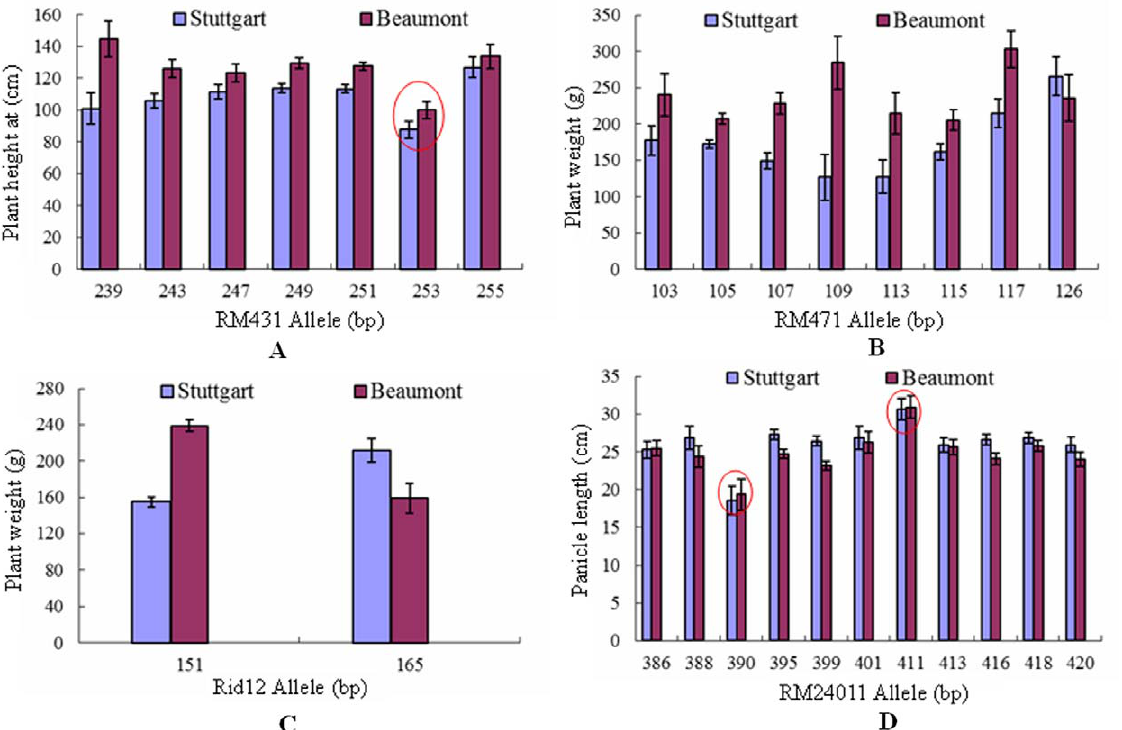
Figure 4. Comparisons of allelic effects of four constitutive marker loci. A: RM431 associated with plant height, B: RM471 and C: Rid12 associated with plant weight, D: RM24011 associated with panicle length constitutively at both Stuttgart, Arkansas and Beaumont,